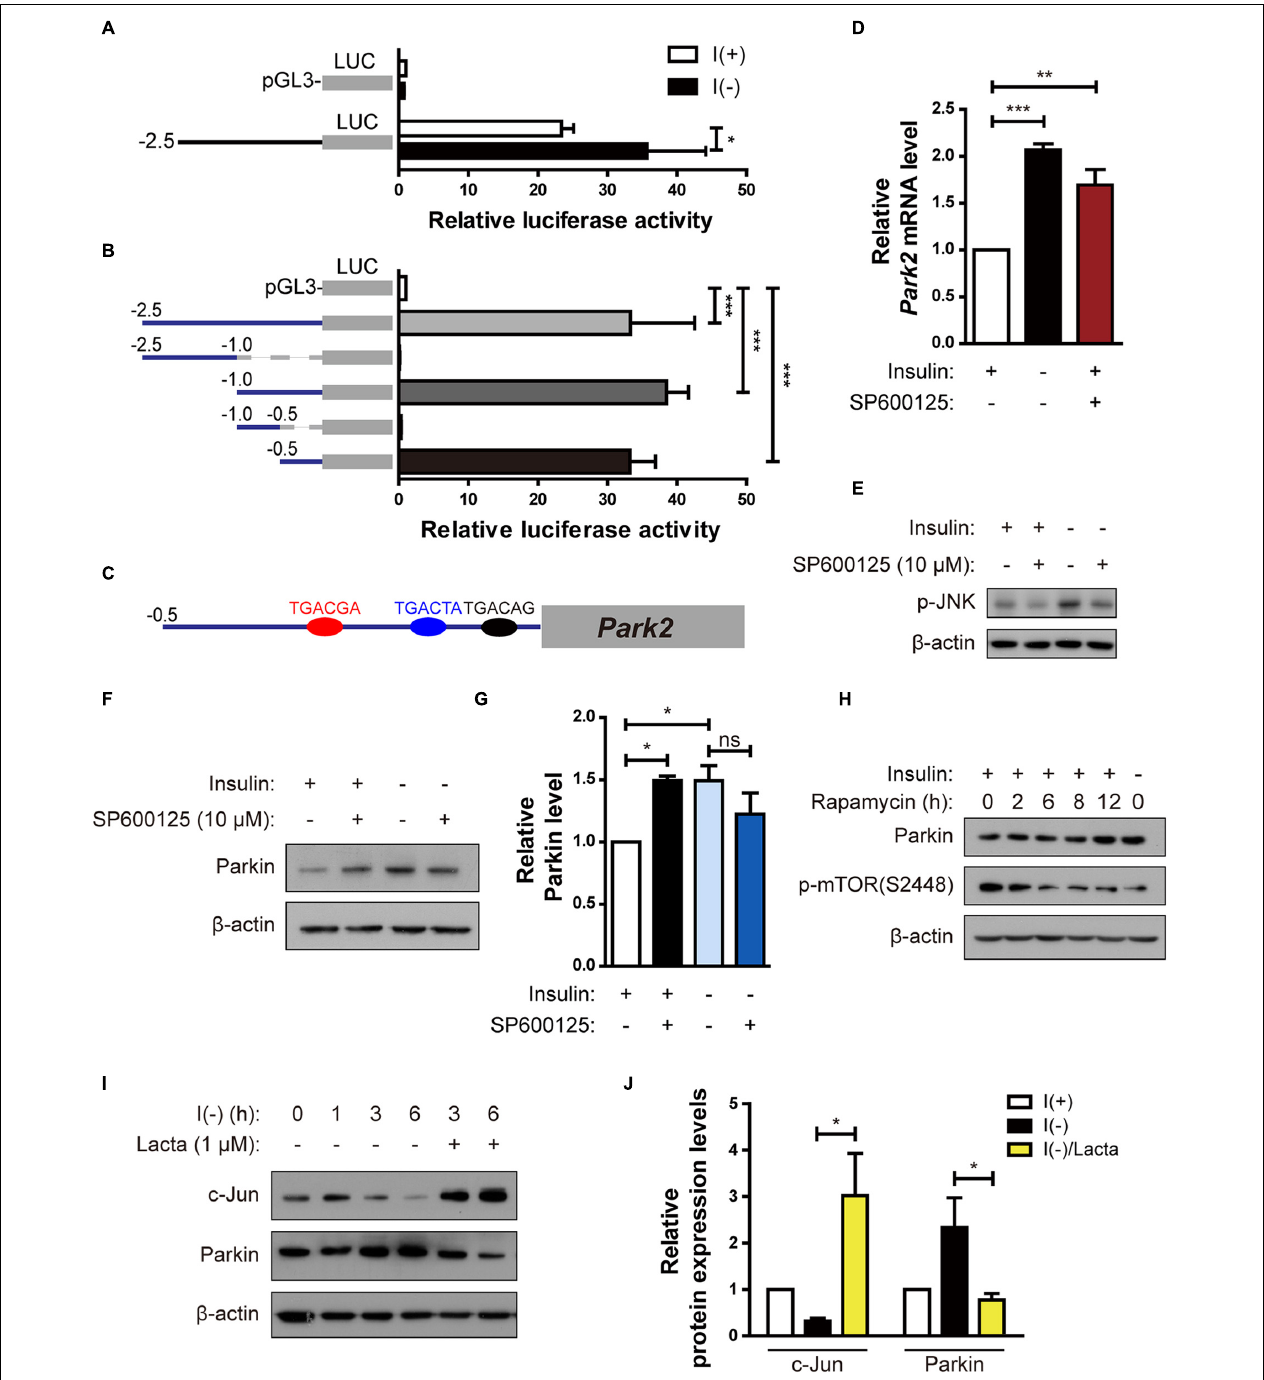
FIGURE 5 | Parkin is upregulated in HCN cells by degradation of c-Jun, a transcriptional repressor, following insulin withdrawal. (A) Luciferase activity assay to analyze Park2 promoter activity after insulin withdrawal for 24 h ( n = 3). (B) Activities of various truncated fragments of the Park2 promoter in I( + ) cells. Promoter activity was measured using a luciferase assay ( n = 3–7). (C) Prediction of c-Jun-binding sites in the Park2 promoter region. (D) Parkin mRNA level in HCN cells treated with SP600125, an ATP-dependent JNK inhibitor, (10 µ M) for 8 h in comparison with that in I(-) HCN cells after insulin withdrawal for 24 h ( n = 3). (E) Western blotting analysis of p-JNK levels in HCN cells after insulin withdrawal for 2 h. SP600125 (10 µ M) was treated 10 µ M for 2 h. The blots shown are representative of three experiments with similar results. (F) Western blotting analysis of Parkin protein levels in SP600125 (10 µ M, 8 h) -treated HCN cells. The blots shown are representative of five experiments with similar results. (G) Quantification of Parkin levels ( n = 5) from (F) . (H) Increased Parkin protein levels in HCN cells treated with Rapamycin (20 nM, 2 h), a mTOR inhibitor. ( I ) Time course analysis of c-Jun protein levels following insulin withdrawal in comparison with lactacystin treatment (Lacta, 1 µ M). (J) Quantification of c-Jun and Parkin protein levels in I(-) HCN cells treated with or without Lacta (1 µ M) for 6 h ( n = 3). ∗ p < 0.05, ∗∗ p < 0.01, ∗∗∗ p < 0.001.